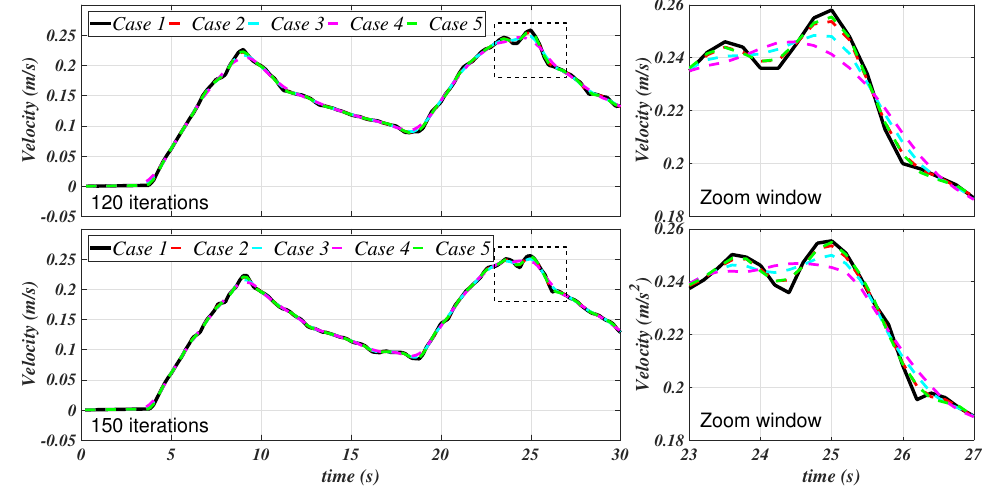
Figure 6. Filtered u for the filtering cases 1–5.